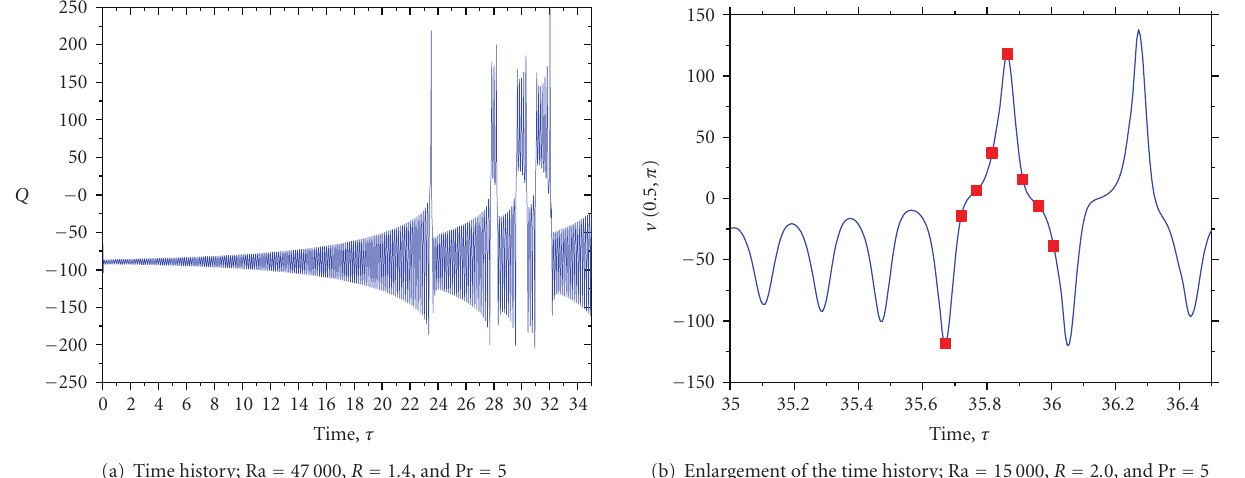
Figure 9: Chaotically reversing